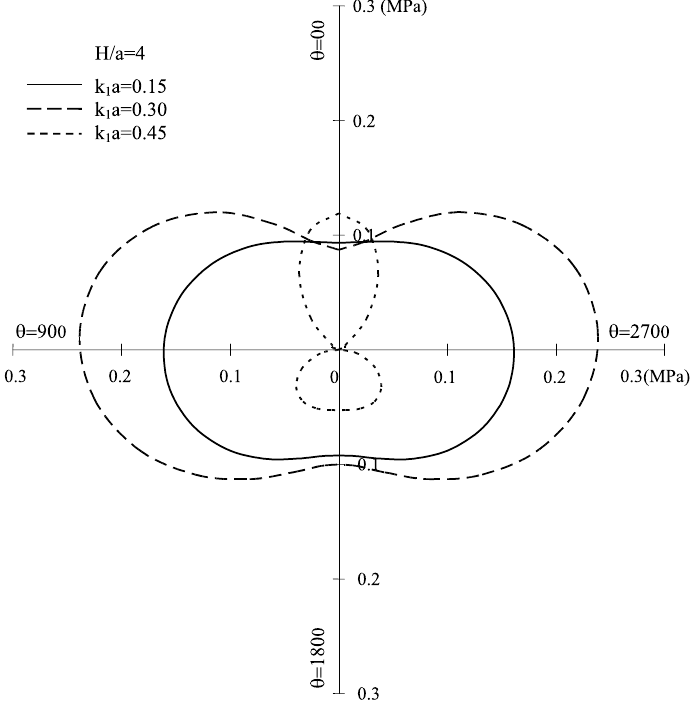
Fig. 4. Variation of the circumferential normal stress ( τ θθ ) with θ at r = a for various values of wave number k 1 a